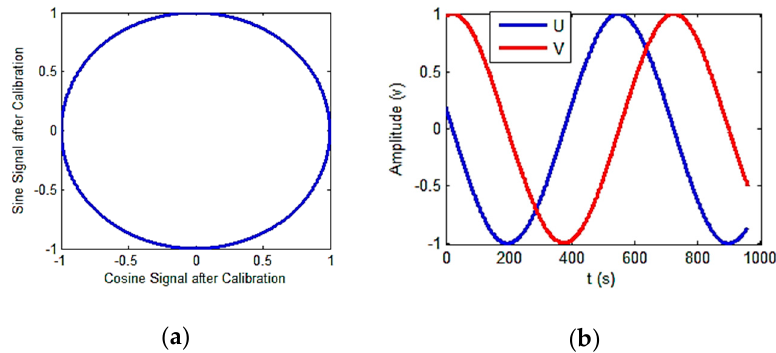
Figure 21. Calibrated signals. ( a ) Calibrated Lissajous figure; ( b ) calibrated sine and cosine signals. The parameter identification results are summarized in Table 2. Table 2. Parameter estimation results from the experiment.